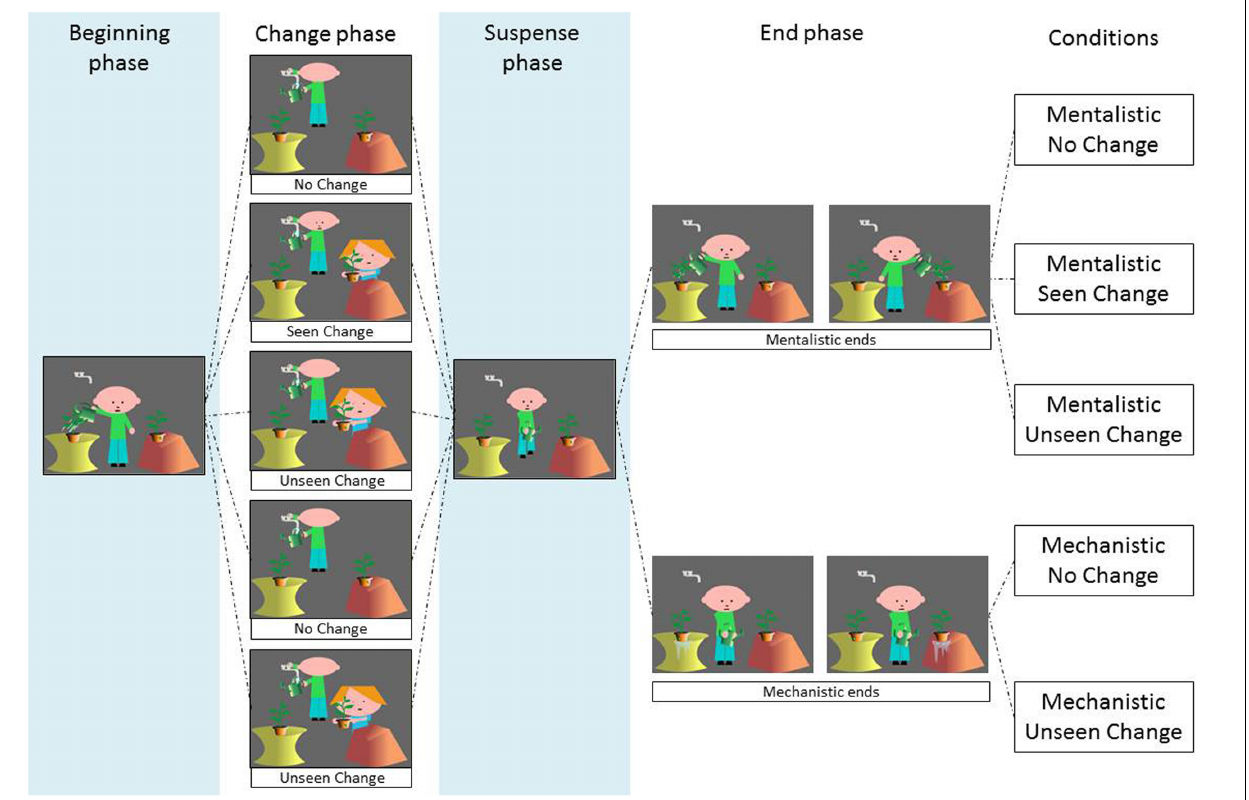
FIGURE 1 | Examples of cartoons presented during the four phases (beginning, change, suspense and possible ends) according to five experimental conditions (adapted from Forgeot d’Arc and Ramus, 2011). The combination of three change phases (No Change, Seen Change, and Unseen Change) with two different end phases (Mentalistic ends and Mechanistic ends) allows the creation of five conditions (Mentalistic No Change, Mentalistic Seen Change, Mentalistic Unseen Change, Mechanistic No Change, and Mechanistic Change). During each end phase, two pictures are presented at the same time and the participant is asked to choose the correct